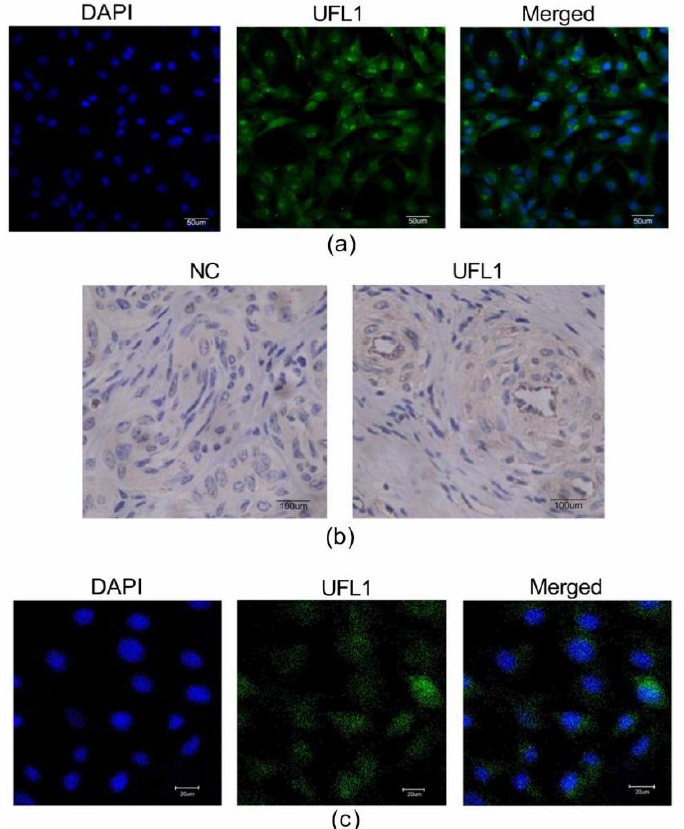
Figure 1. Ubiquitin-like modifier 1 ligating enzyme 1 (UFL1) is expressed in ovarian tissue and the cytoplasm and nucleus of granulosa cells. ( a ) More than 95% of the cells in the isolated cultured cells are ovarian granulosa cells. Identification of ovarian granulosa cells by immunofluorescence. ( b ) Immunofluorescent staining of bovine (ovarian) granulosa cells (bGCs) with anti-UFL1 antibody. ( c ) Bovine ovaries were analyzed by immunohistochemistry.